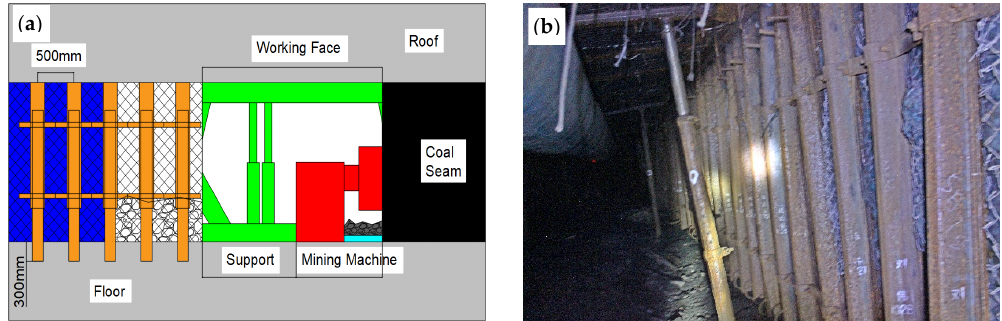
Figure 16. Design and construction of gangue-rib support: ( a ) design; ( b ) construction.